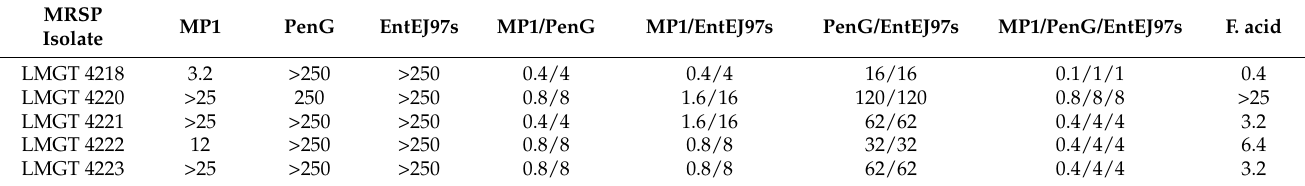
Table 2. MIC 50 values ( µ g/mL) of MP1, PenG and EntEJ97s against five MRSP strains, assessed individually and in combination after microtiter plates were incubated for 72 h at 37 ◦ C (average of triplicate tests). Fusidic acid (F. acid) was used here for comparison.